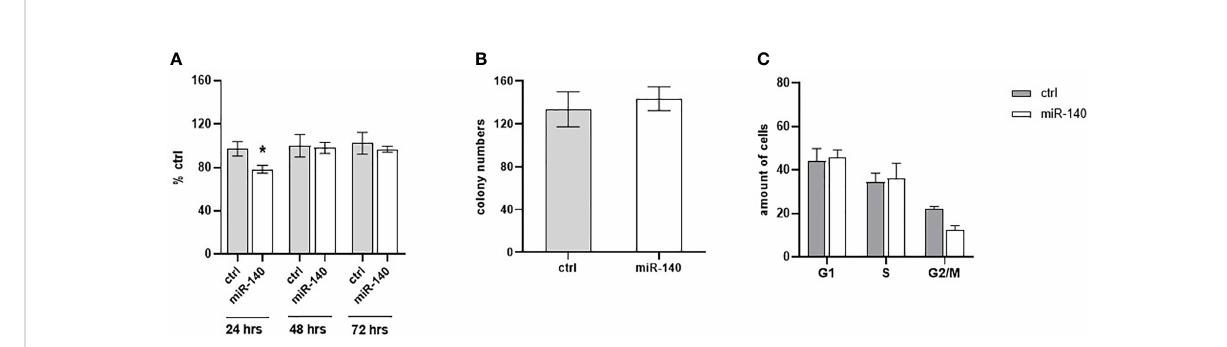
FIGURE 5 Effect of miR-140 on colorectal cancer cells. (A) Proliferation analysis showed a decreased level of proliferation in cells overexpressed miR-140 after 24 h (p = 0.05). (B) miR-140 overexpression did not affect the clonogenic potential of the cells. (C) Analysis of cell cycle content showed moderate accumulation of cells in the G1 phase. The results represent the mean value of three independent experiments ± SD. *p ≤ 0.05.